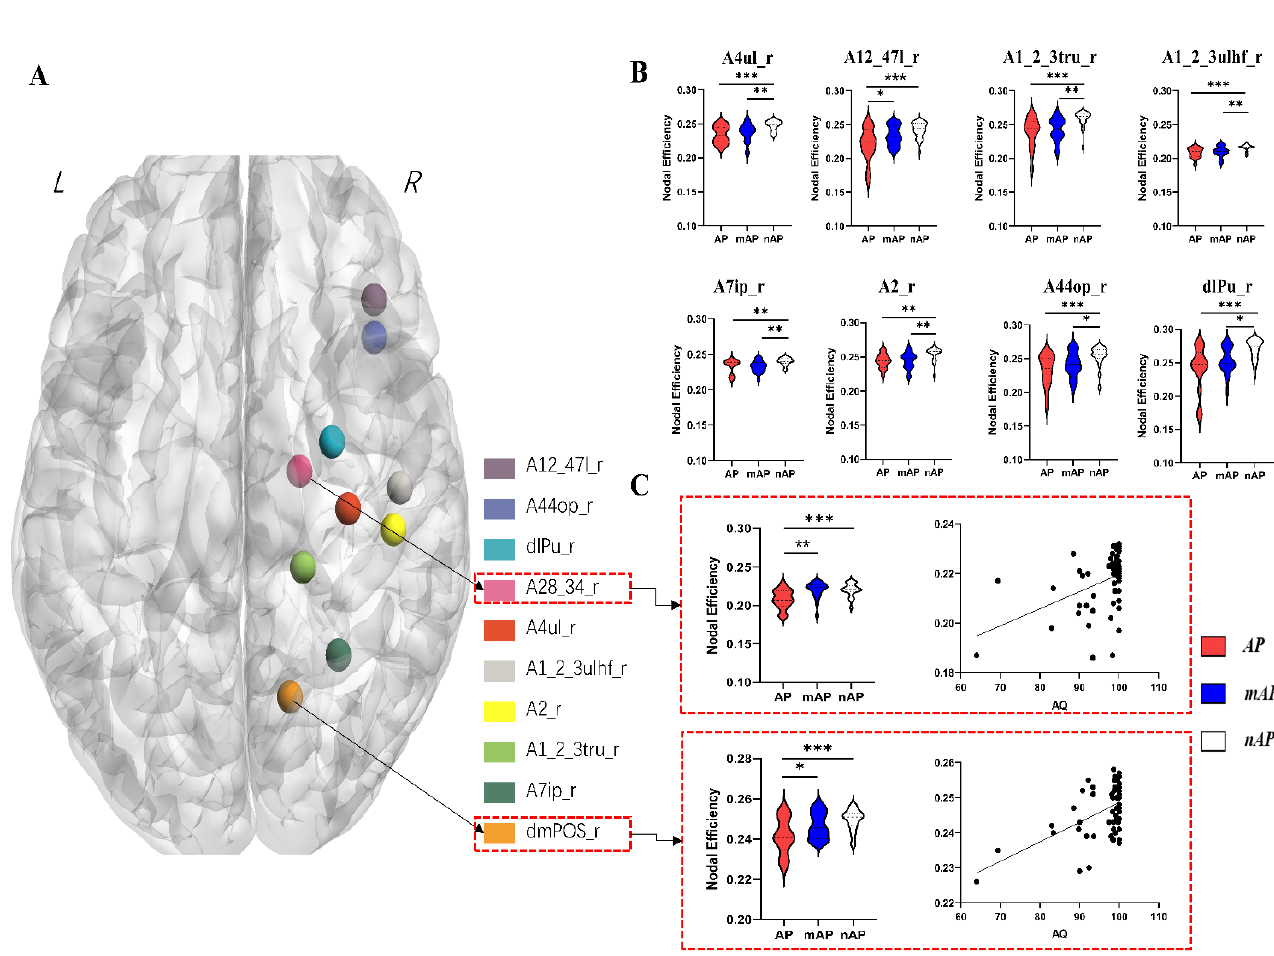
Table 3. Significant alterations of nodal efficiency.